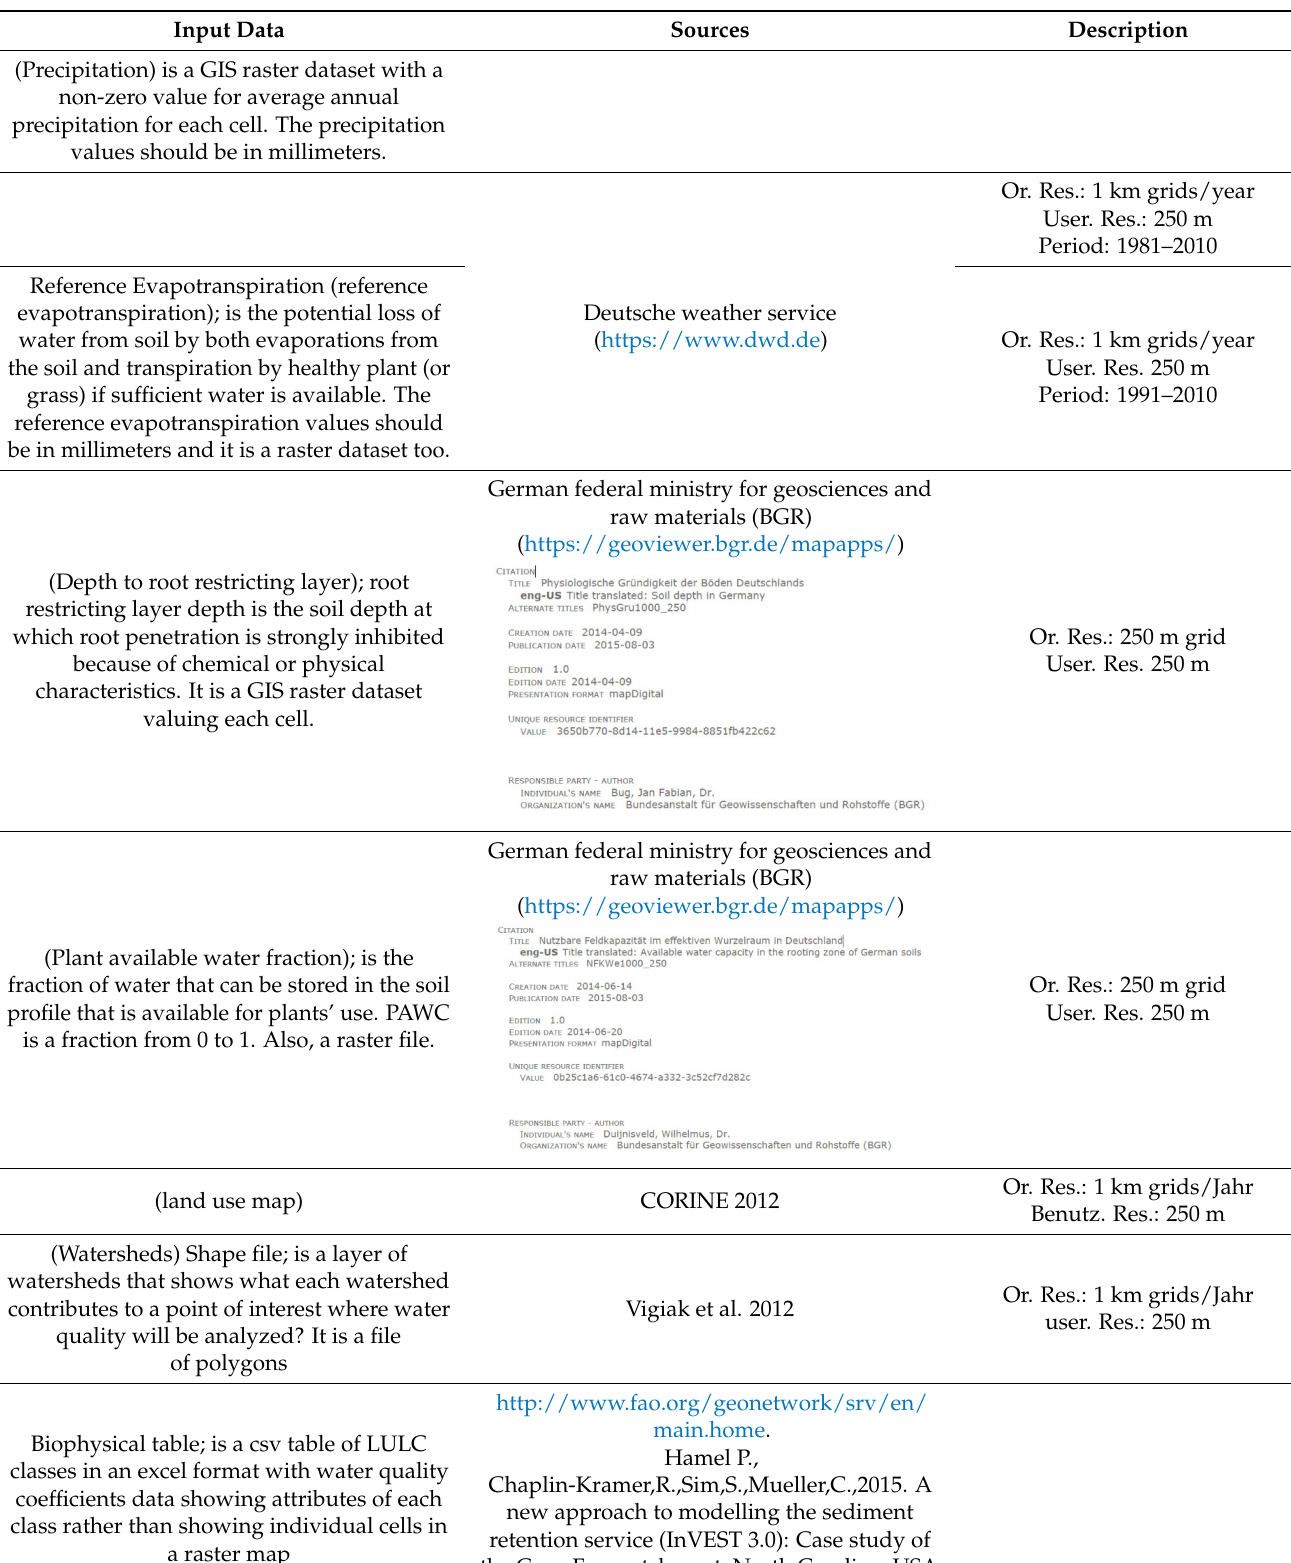
Biophysical table; is a csv table of LULC classes in an excel format with water quality coefficients data showing attributes of